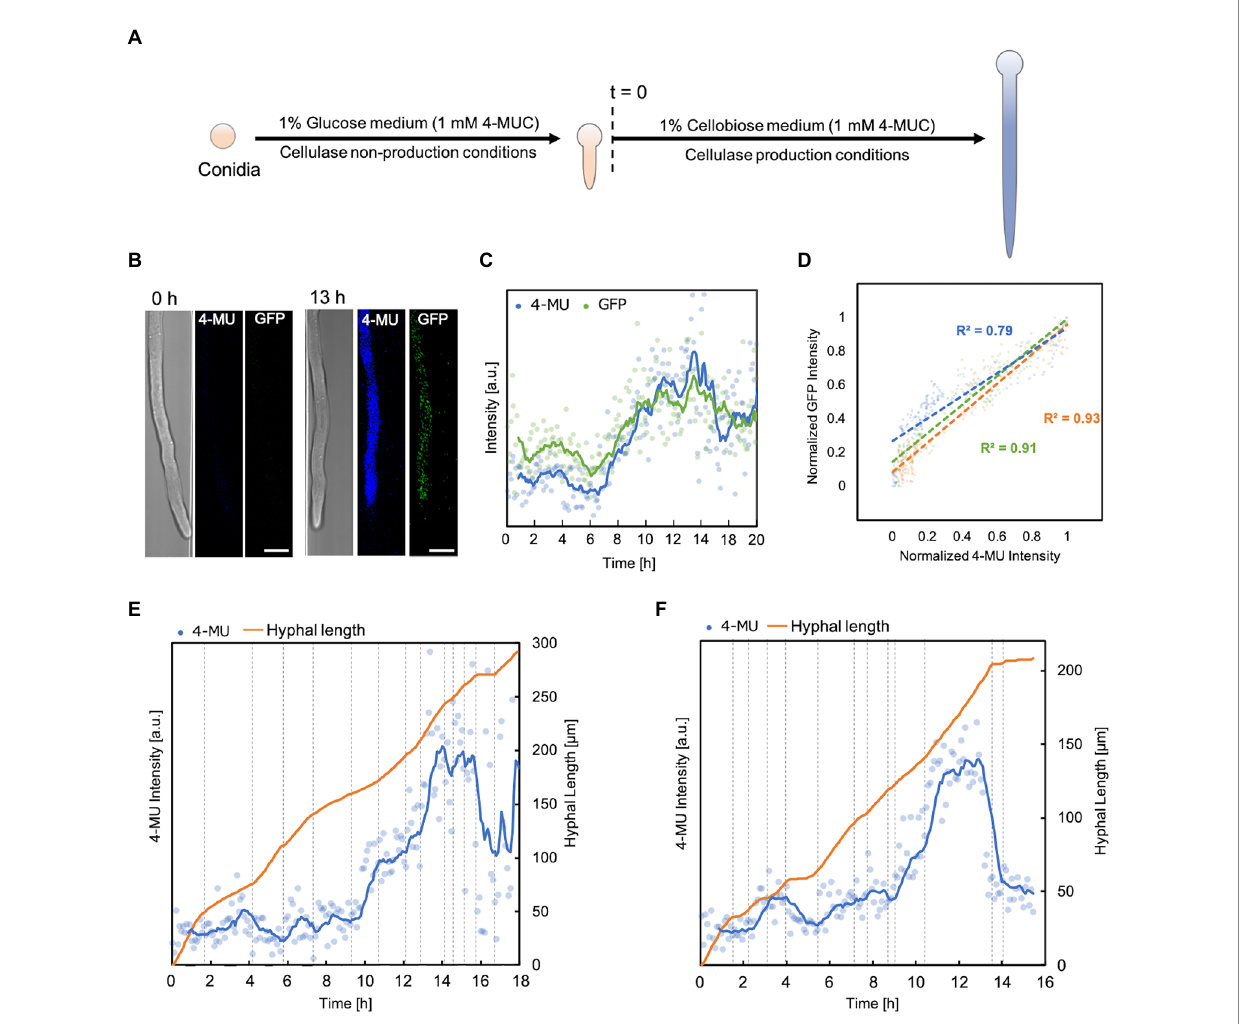
FIGURE 4 Correlation between fluorescence intensity and elongation of hypha. (A) Flowchart of enzyme production and hyphal elongation measurements in the 4-MUC assay. Time of switch to enzyme production medium ( t = 0). (B) Fluorescence images from 4-MUC assay using PC cbh1gfp strain at the time of medium switch ( t = 0 h) and at the time when the highest fluorescence was observed ( t = 13 h). Scale bar: 5 μ m. (C) Fluorescence intensity of 4-MU and GFP in hypha. Channel width: 7.5 μ m. (D) The normalized plot of 4-MU and GFP fluorescence intensity. Channel width: 15 μ m (blue), 10 μ m (green), and 7.5 μ m (orange). (E,F) 4-MU fluorescence intensity and hyphal elongation profile. Channel width: 7.5 μ m (E) , 15 μ m (F)